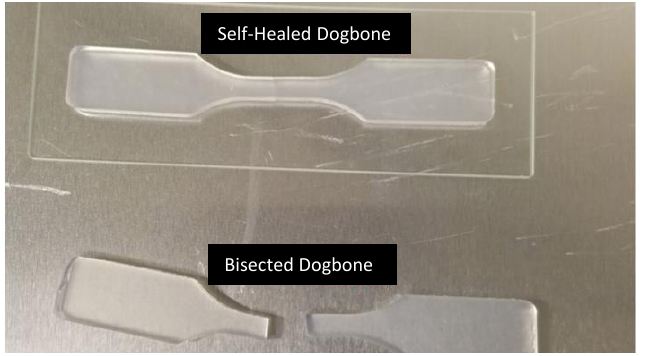
Figure 12. Pseudo-self-healing demonstration of bisected specimen of ExSil ® (Author’s